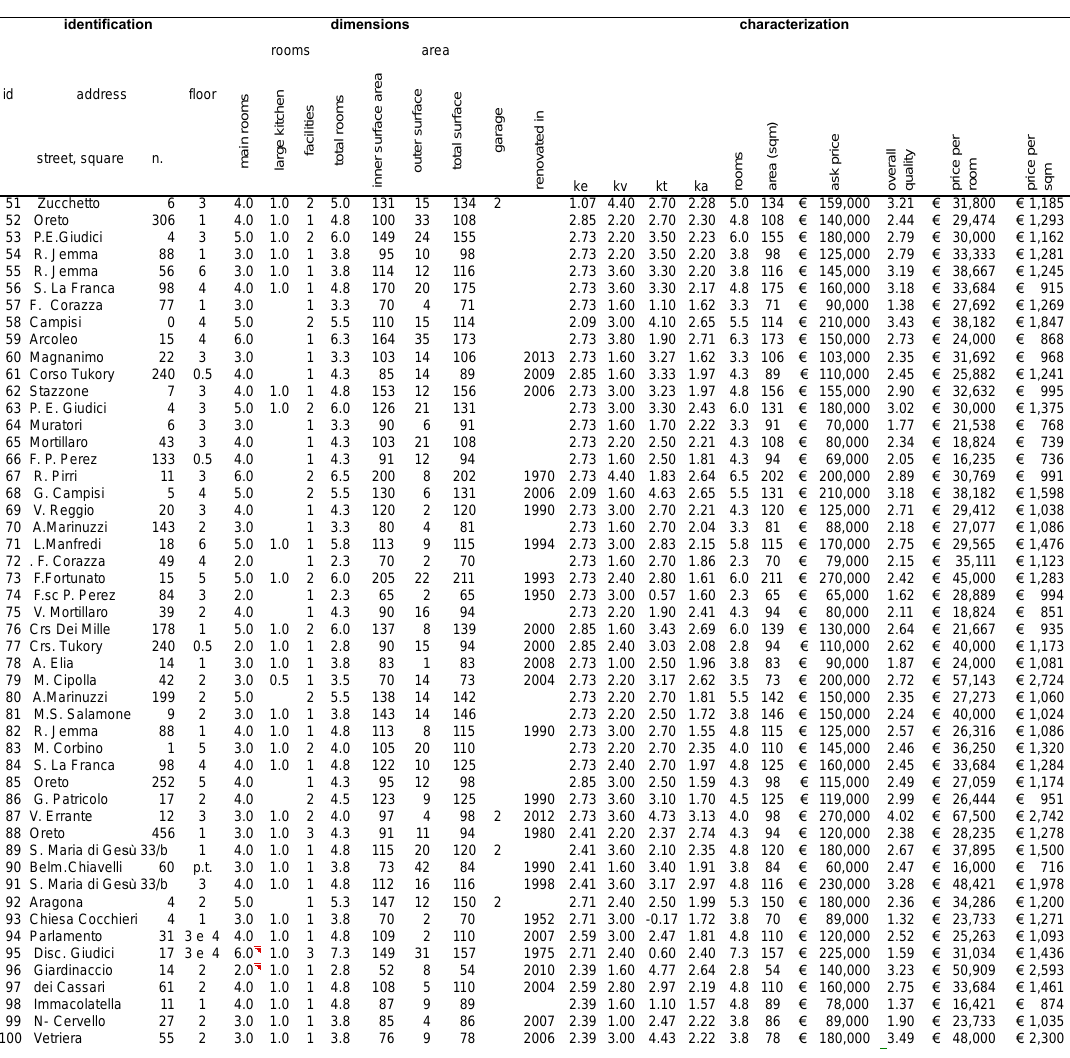
Table 3. Distribution of the samples of properties for sale and for rent by neighbourhood.